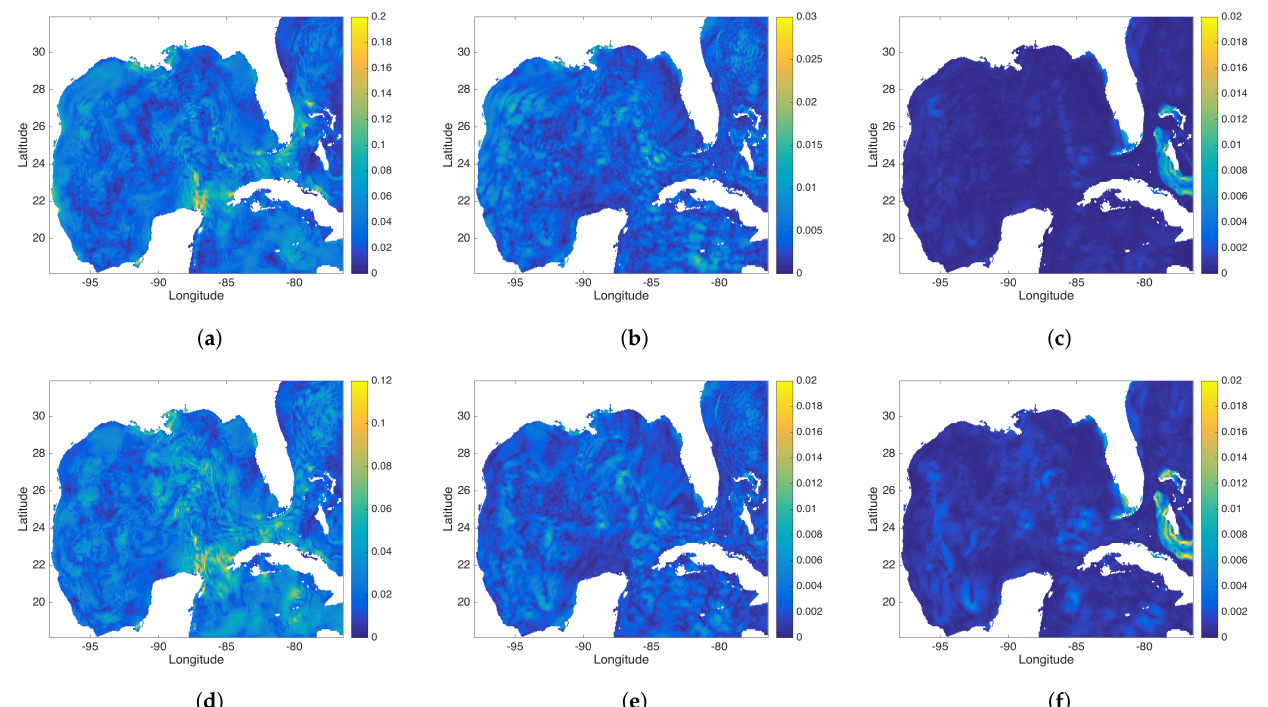
Figure 14. ( a – c ) represent the exact DMD modes 3, 4, and 5 and ( d – f ) show the rDMD modes 3, 4, and 5. Mode 3 is a diurnal mode with period 23.85 h for the exact DMD case and 24.56 h for the rDMD case. Modes 4 and 5 are associated with the second and third harmonic of semi-diurnal tidal constituents,